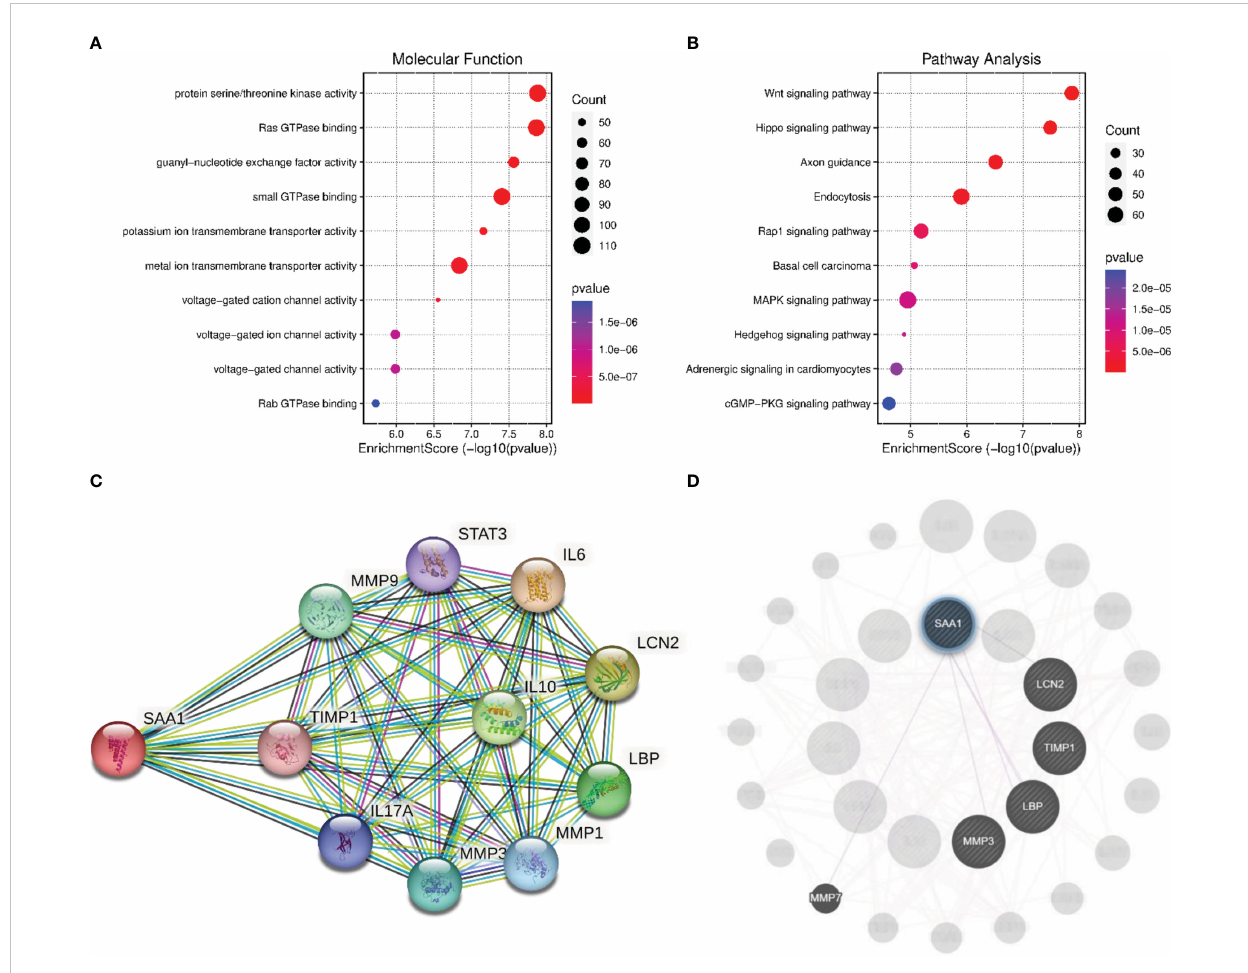
FIGURE 6 Enrichment analysis and PPI network analysis for SAA1. (A) The enriched molecular function items for the co-expressed items for the co-expressed genes of SAA1. (B) The enriched Kyoto Encyclopedia of Genes and Genomes (KEGG) items for the co-expressed items for the co-expressed genes of SAA1. (C) Protein network diagram of interaction with SAA1 created base on the STRING database. (D) Protein network diagram of interaction with SAA1 created using GeneMANIA